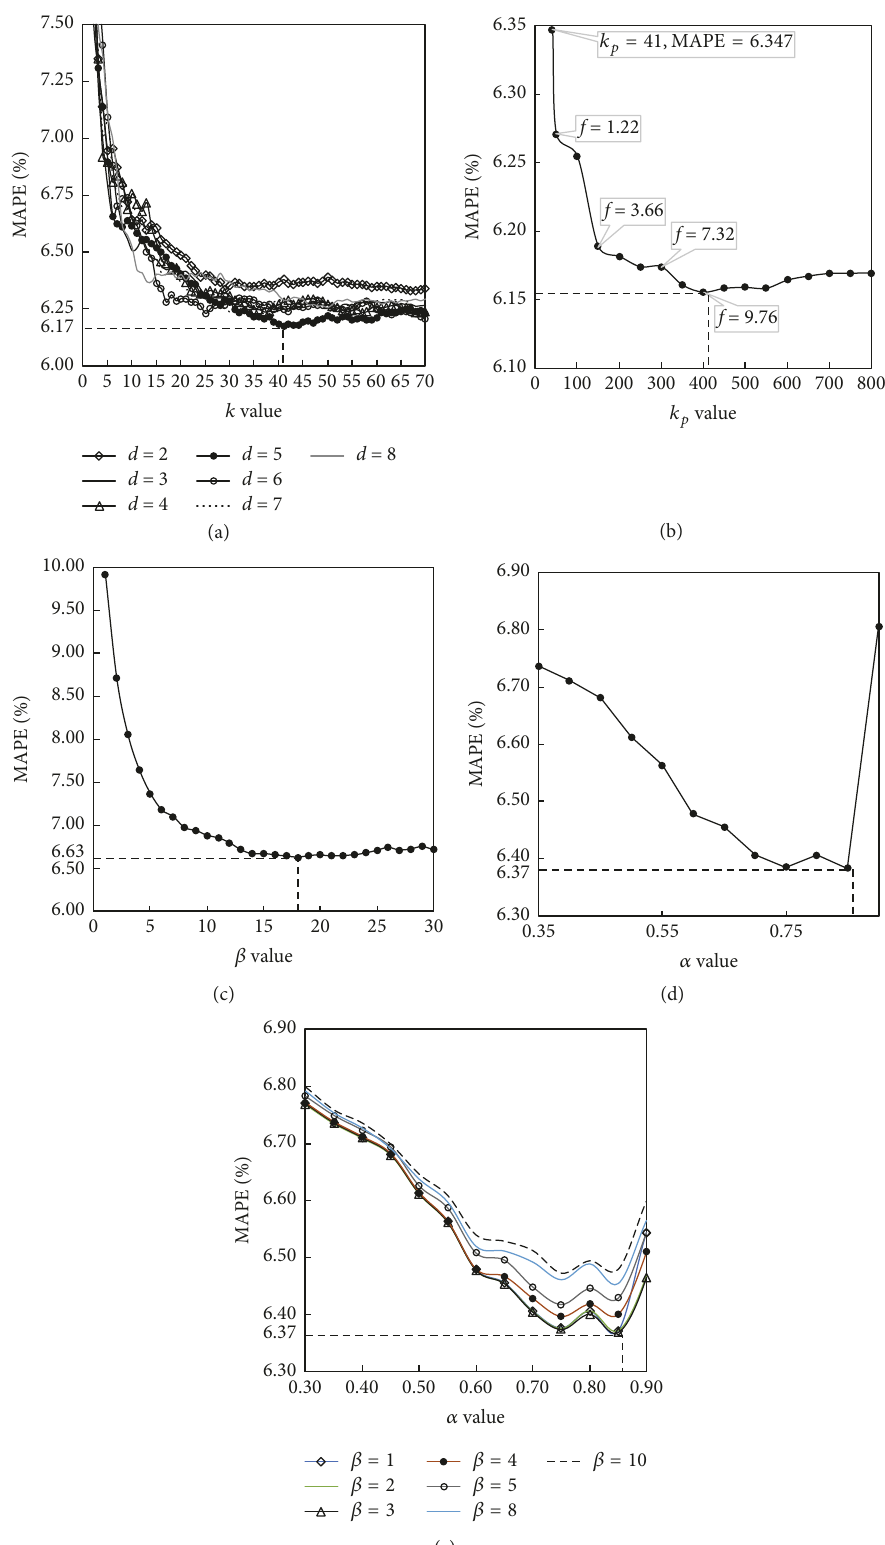
Figure 3: Effects of model parameters on prediction errors. (a) Effects of 𝑑 and 𝑘 values; (b) effects of the 𝑘 𝑝 value with 𝑑 𝑜 and 𝑘 𝑜 values; (c) effects of the 𝛽 value; (d) effects of the 𝛼 value; and (e) effects of 𝛼 and 𝛽